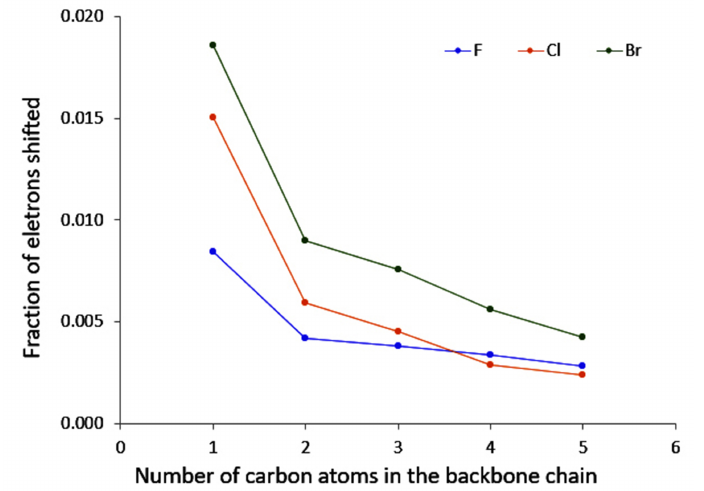
Figure 6. Evolution of the fraction of electron shifted when the carbon neighbour to the halogen is perturbed with respect to the number of carbon atoms in the backbone